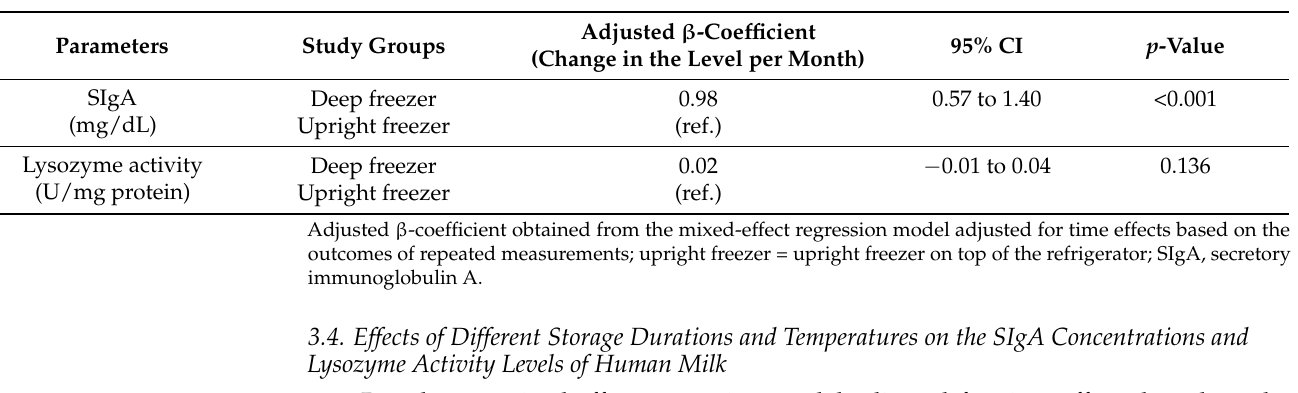
Figure 3. Comparison of lysozyme activities between fresh, refrigerated (2 °C), frozen at −16.7 °C, and frozen at −22.3 °C HM samples. The data were analyzed using Kruskal–Wallis test with Bonferroni correction for pairwise comparisons. The lysozyme activities are presented as the medians and percentiles (25th, 75th). * p < 0.05 and ** p < 0.001. Table 4. Changes in SIgA concentrations and lysozyme activities of human milk, comparing storage in a deep freezer (−22.3 °C) and in an upright freezer on top of a refrigerator (−18.7 °C) over a six-month period.